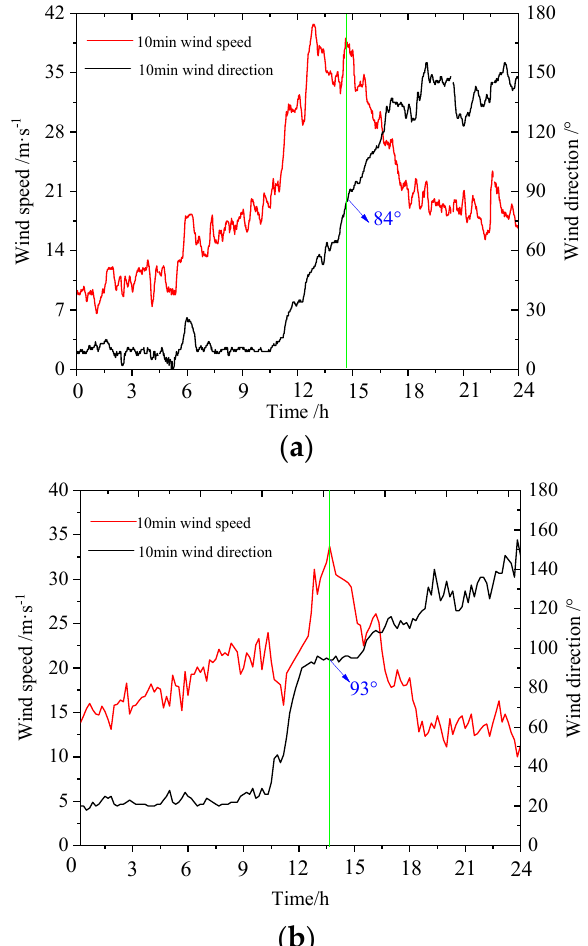
Figure 3. Observations of wind speed and direction at the sites of NLDI and PAFC during Typhoon Manghut: ( a ) NLDI; ( b ) PAFC.